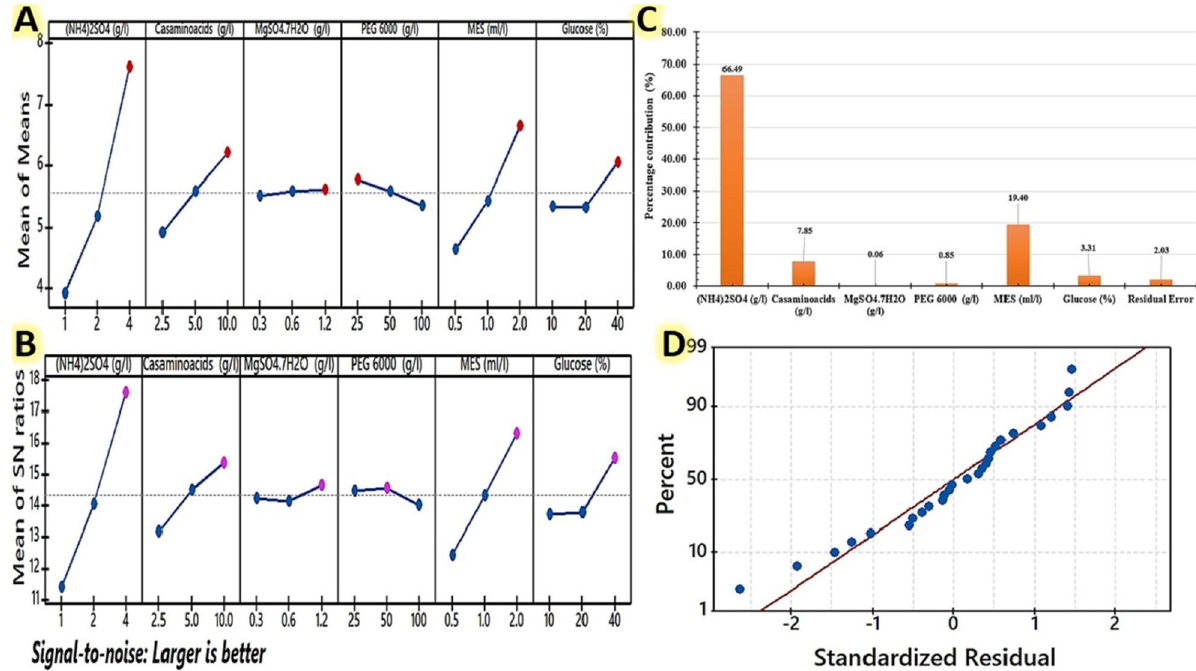
Figure 4. Characterizes Taguchi’s experimental results; ( A ) the main effects plot for the mean of produced cell dry weight of strain E56; ( B ): the larger-the-better main effects plot for S/N ratios, with the horizontal axis indicating the different levels of each significant component and the lines representing the trend of each factor with respect to different levels. ( C ): the percentage contribution of each factor to the cell dry weight yield. ( D ): the residual normal probability